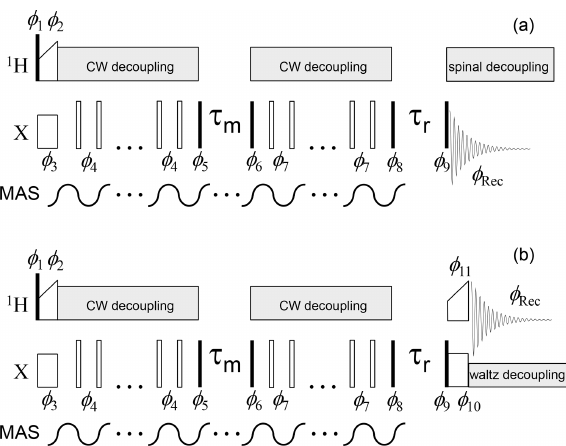
Figure 3. CSA CODEX pulse sequence for the direct ( 13 C or 15 N, a ) and indirect ( 1 H, b ) signal detections. Solid and open bars denote π/ 2 and π pulses, respectively. The mixing time τ m is an integer multiple of the MAS period, which is achieved by MAS rotor triggering before and at the end of the mixing time (see details in Reichert and Krushelnitsky, 2018). Rotor synchronization during the τ r delay is not necessary. Waltz decoupling in the indirect detection sequence aims to suppress only J coupling between X and 1 H nuclei; therefore, it has a low amplitude (a few hundred Hz). An additional initial Z filter and 2 H decoupling (see below) are not shown.